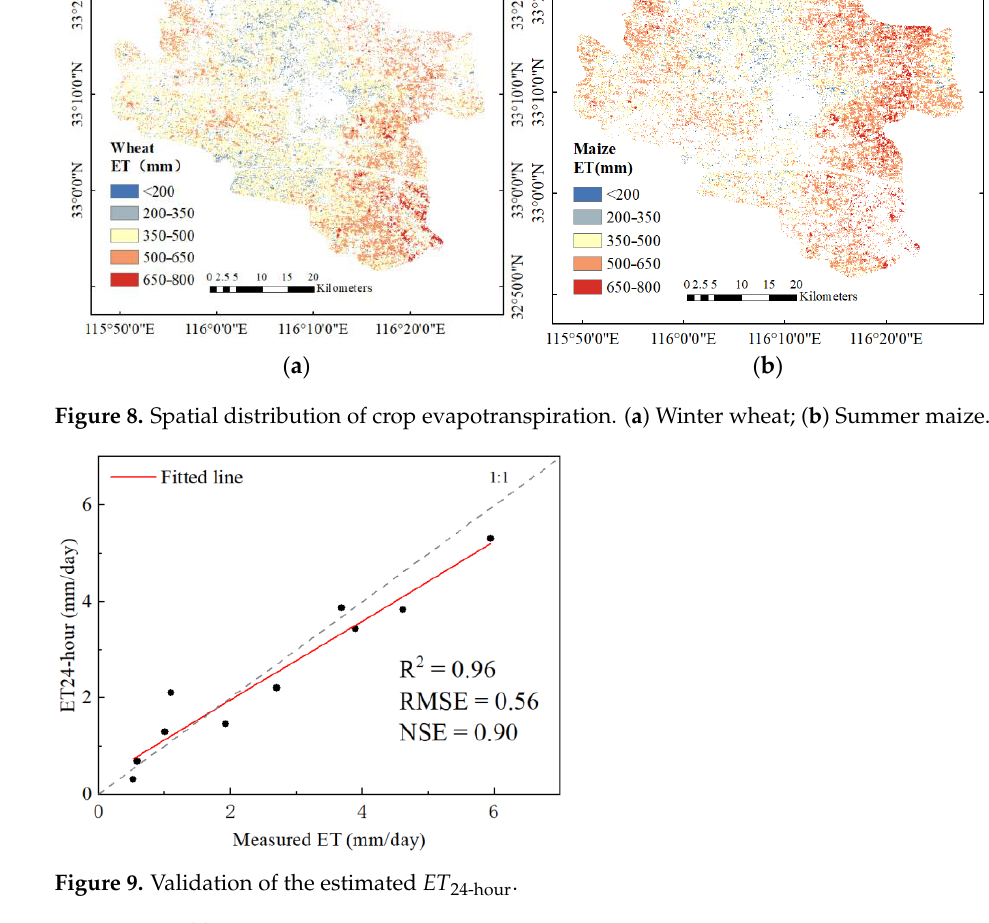
Figure 9. Validation of the estimated ET 24-hour .